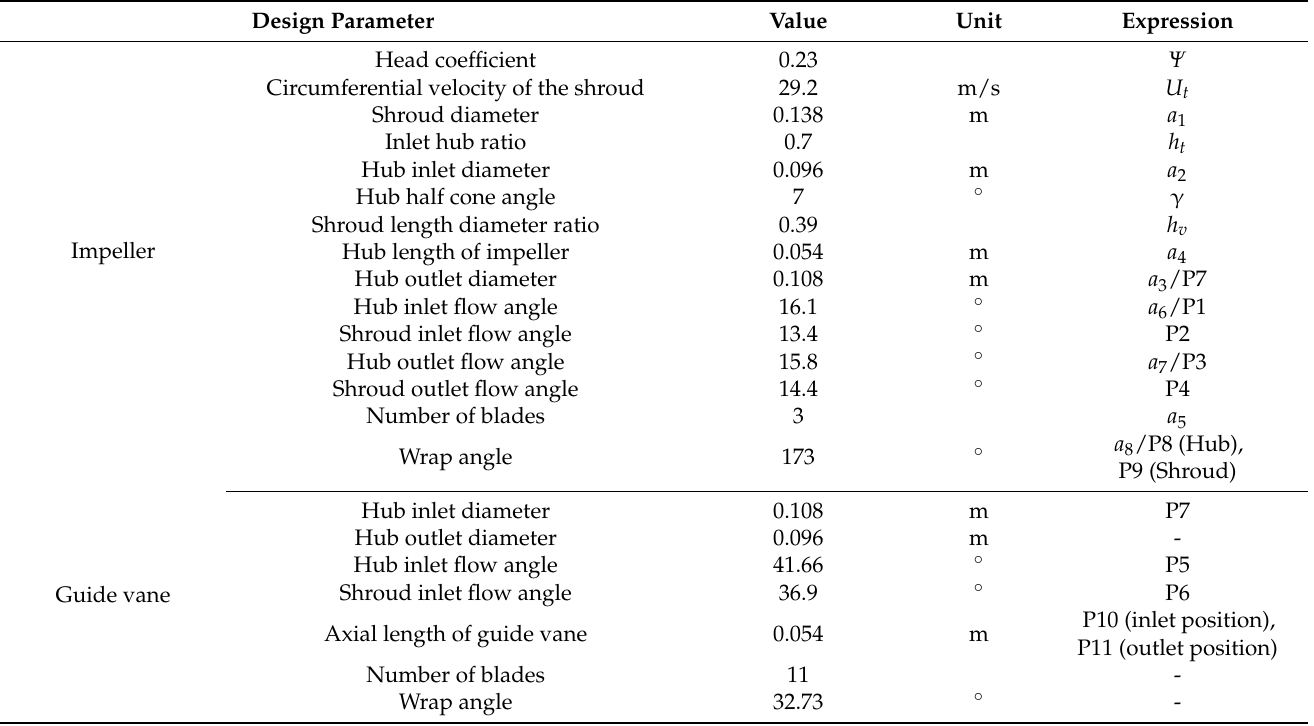
Table 2. Design and construction parameters of the multiphase pump.